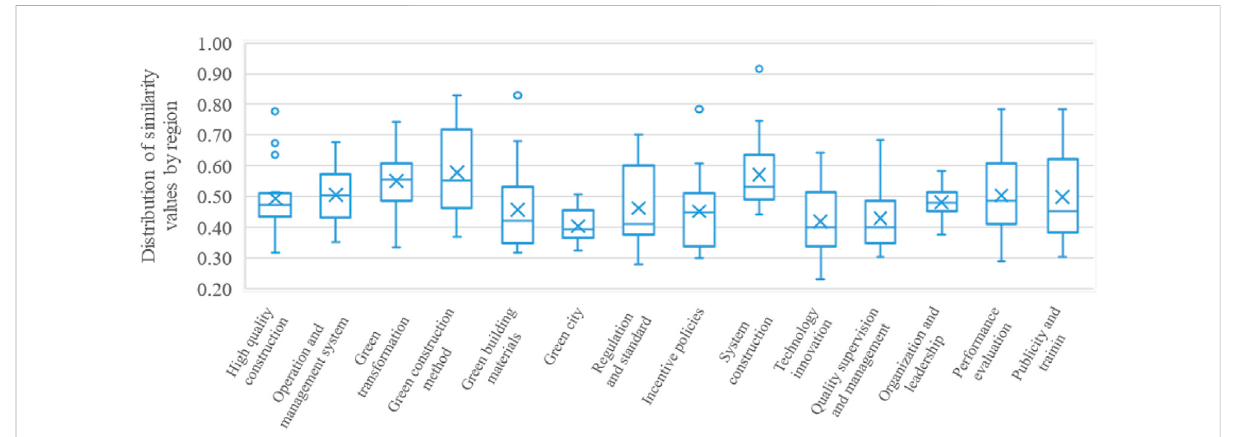
FIGURE 2 Numerical distribution of similarity of speci fi c indicators of the 14th Five-Year